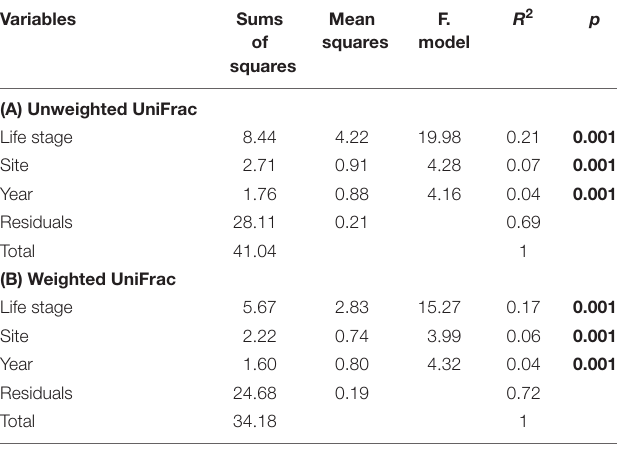
TABLE 2 | Summary of PERMANOVA models of (A) Unweighted and (B) Weighted UniFrac distances according to life stage, study site, and year. Variables